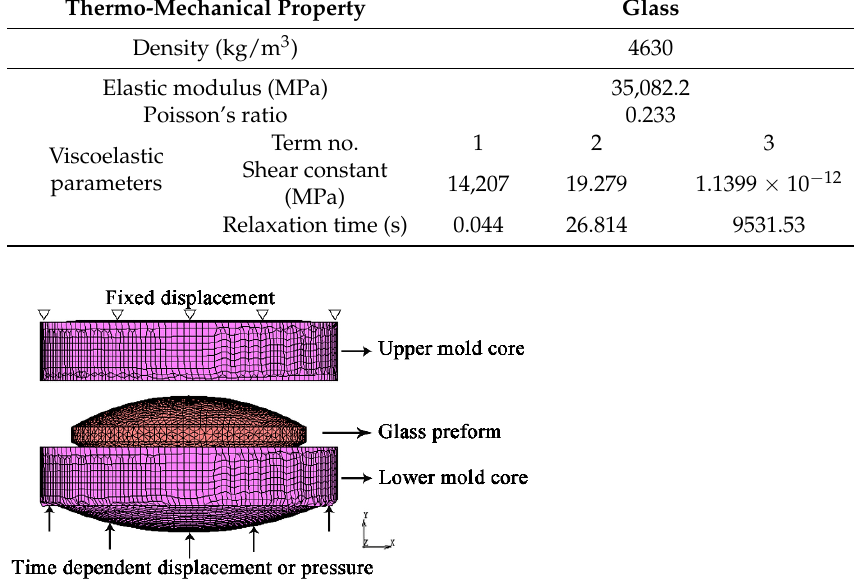
Figure 6. The diagram of established finite element model with boundary conditions. Table 4. Thermodynamic characteristics of the glass and mold used in the simulation.